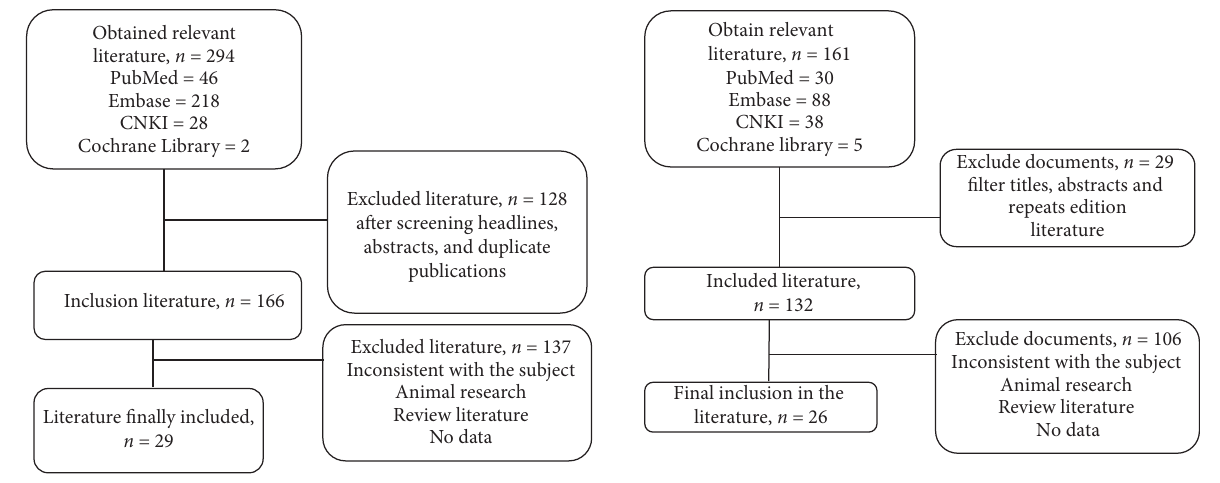
Figure 1: The process of study selection.